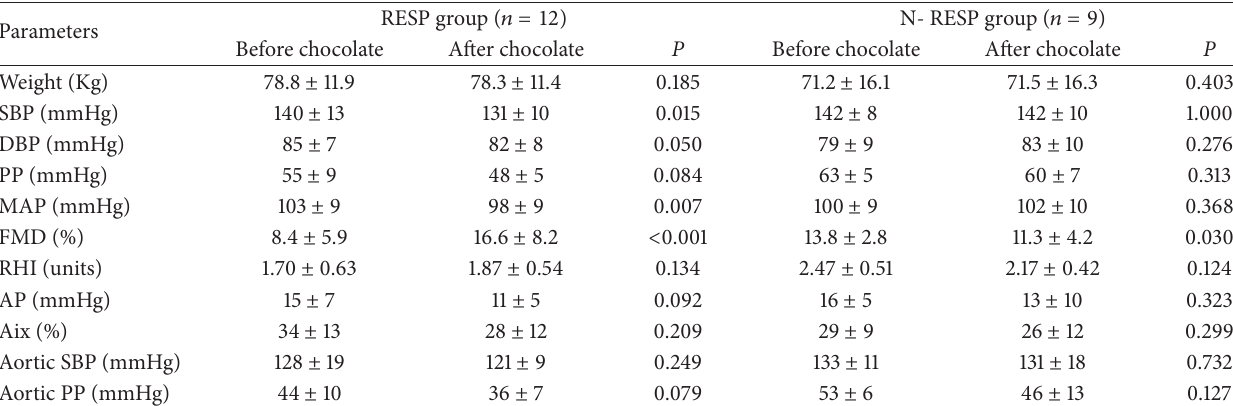
Table 2: Clinical and vascular parameters in responder (RESP) and nonresponder (N-RESP) groups before and after chocolate consumption.